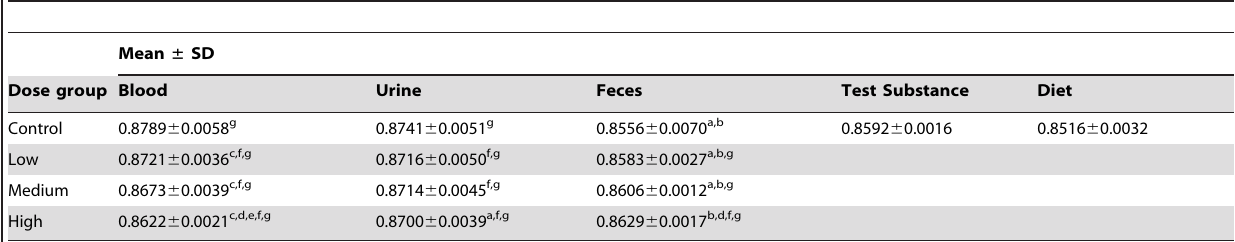
Table 3. Statistical significance of differences in 207 Pb/ 206 Pb for test substance, diet, blood, urine, and feces in different dose groups (n= 6) of respiratory lead